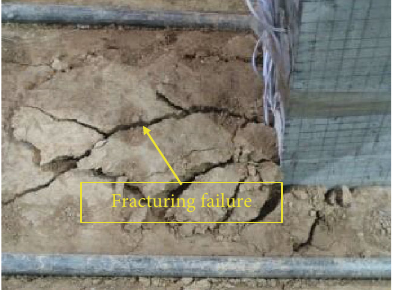
Figure 19: Fracturing damage of soil in front of